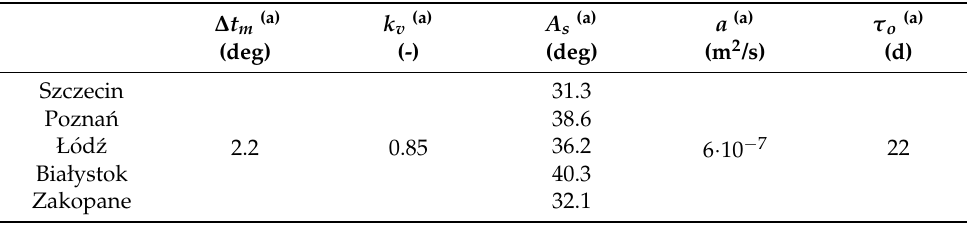
Table 7. The data to the Baggs formula (Formula (2)).